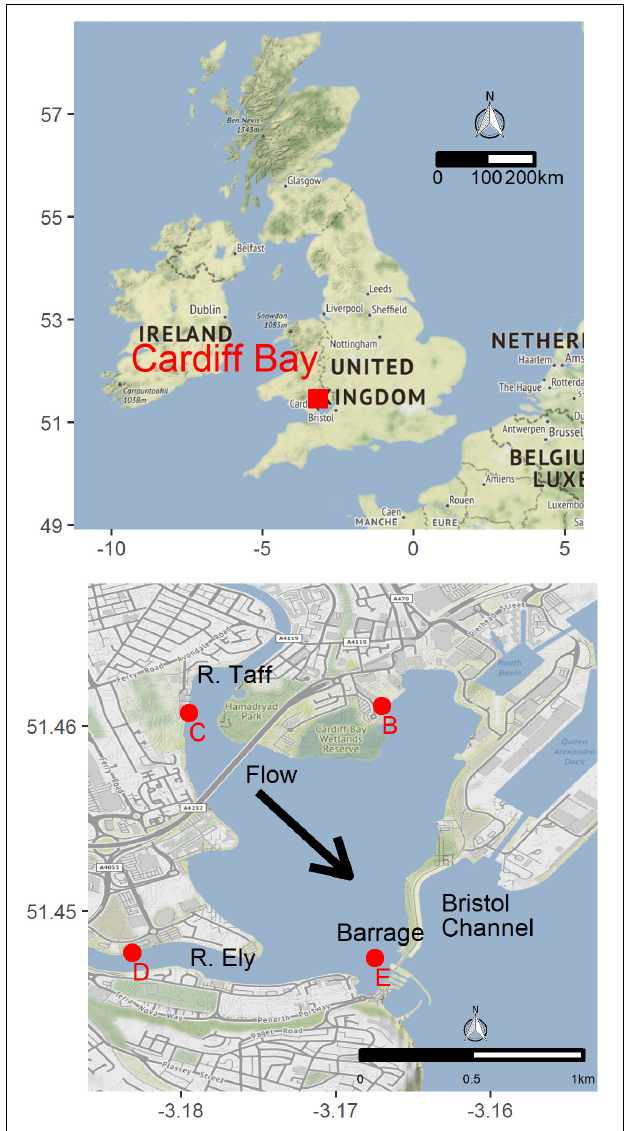
FIGURE 1 | Study site for zebra mussel population dynamics (Cardiff Bay, United Kingdom) showing location of experimental buoys (B–E) used to sample new recruits.